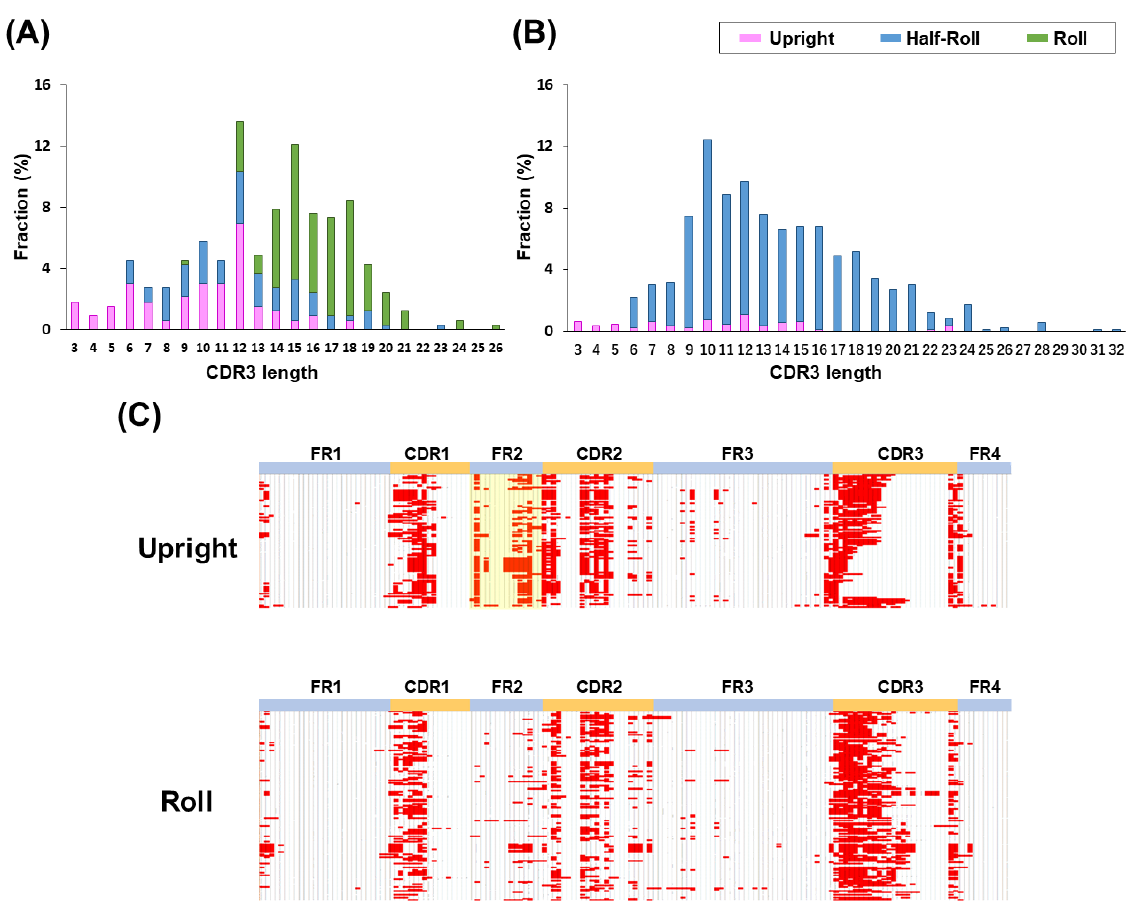
Figure 1. Classification of VHHs by CDR3 loop structures. ( A ) The structure of VHHs is classified into three types based on the conformation of CDR3; Upright , Half-Roll and Roll (PDB ID: 5j1s, 6ru3, and 2p45). ( B , C ) The distances between C α atoms of CDR3 loop and FR2 (distance between H46 residue and (n − 5)th residue with H102 as (n)th residue) and pseudo-dihedral angles of CDR3 C- terminal (dihedral angle consisting of the four C α atoms of the (n+1)th, (n)th, (n − 1)th, and (n − 2)th residues, with H102 as the (n)th residue) were calculated from structures and the value was plotted. ( B ) The structures of CDR3 were classified into the three groups according to type ( Upright , Roll , and Half-roll ) based on the distance and pseudo-dihedral angle. The VHHs belonging in the Upright group (pink dots) had a distance of 15Å or more and an angle of 140° to 360°, the VHHs in the Roll group (green dots) had a distance of 10Å or more and an angle of less than 140°, and the other VHHs were classified as the Half-Roll type (blue dots). ( C ) The CDR3 of human VH (gray dots) from a conventional VH–VL complex and VHH (yellow dots) are shown.